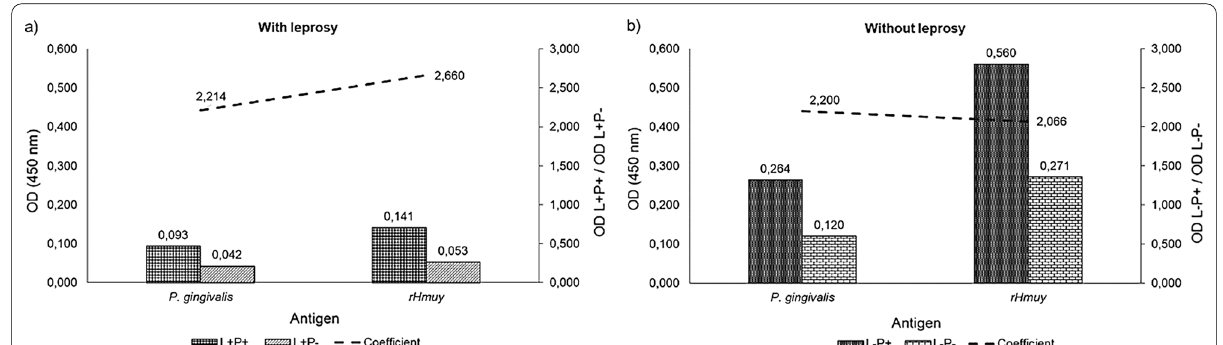
Fig. 1 a Average optic density for pools of individuals with leprosy and with periodontitis (L + P + ) and individuals with leprosy and without periodontitis (L + P − ). b Average optic density for pools of individuals without leprosy and with periodontitis (L − P + ) and individuals without leprosy and without periodontitis (L − P −